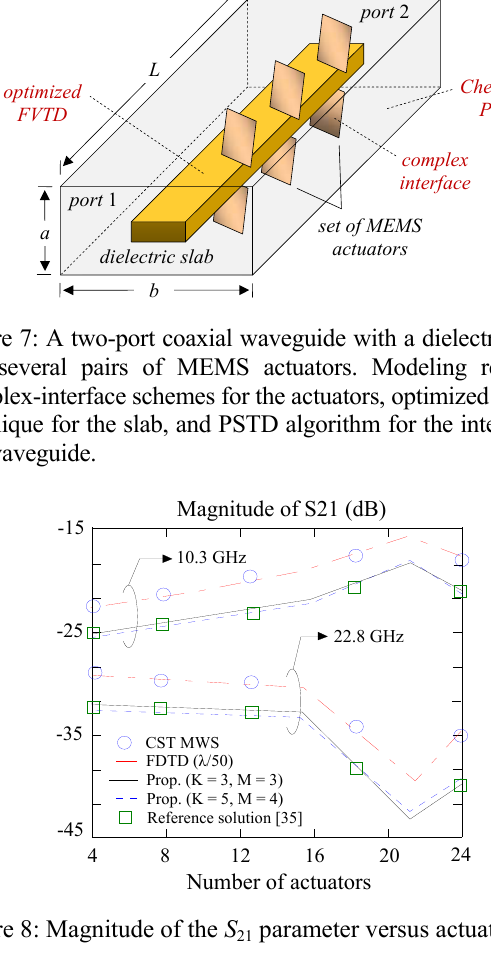
Figure 6: Return loss of the wideband 25×1 patch array. optimal design of this large-scale array needs a trustworthy simulation means. Dimensions are: L = 18 mm, L = 26 mm, h = 0.19 mm, w = 3.1 mm, d = 2.8 mm